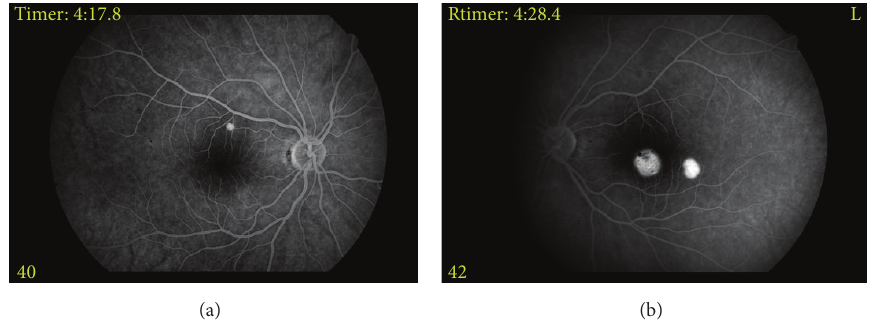
Figure 3: Early-phase FA revealed hyperfluorescent areas (fluorescence pooling) in PED but no findings such as leakage or fluorescence expansion could be detected ((a),